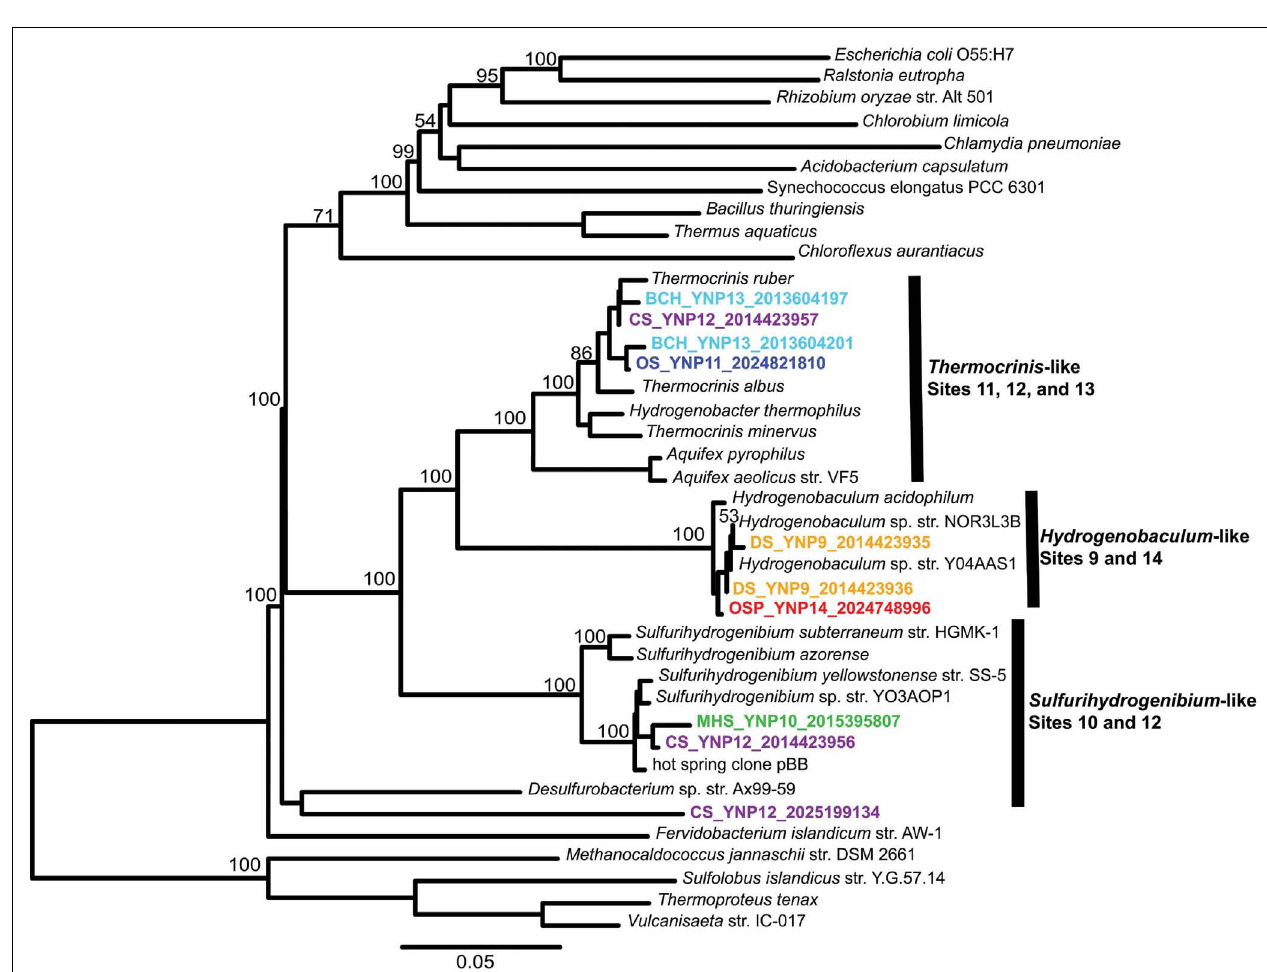
FIGURE 4 | Phylogenetic tree ofAquificales 16S rRNA gene sequences observed within assembled metagenome sequence from sixYNP geothermal outflow channels [DS_9 (orange), OSP_14 (red), MHS_10 (green), CS_12 (violet), OS_11 (dark-blue), BCH_13 (light-blue) [neighbor-joining tree with 1000 bootstraps]